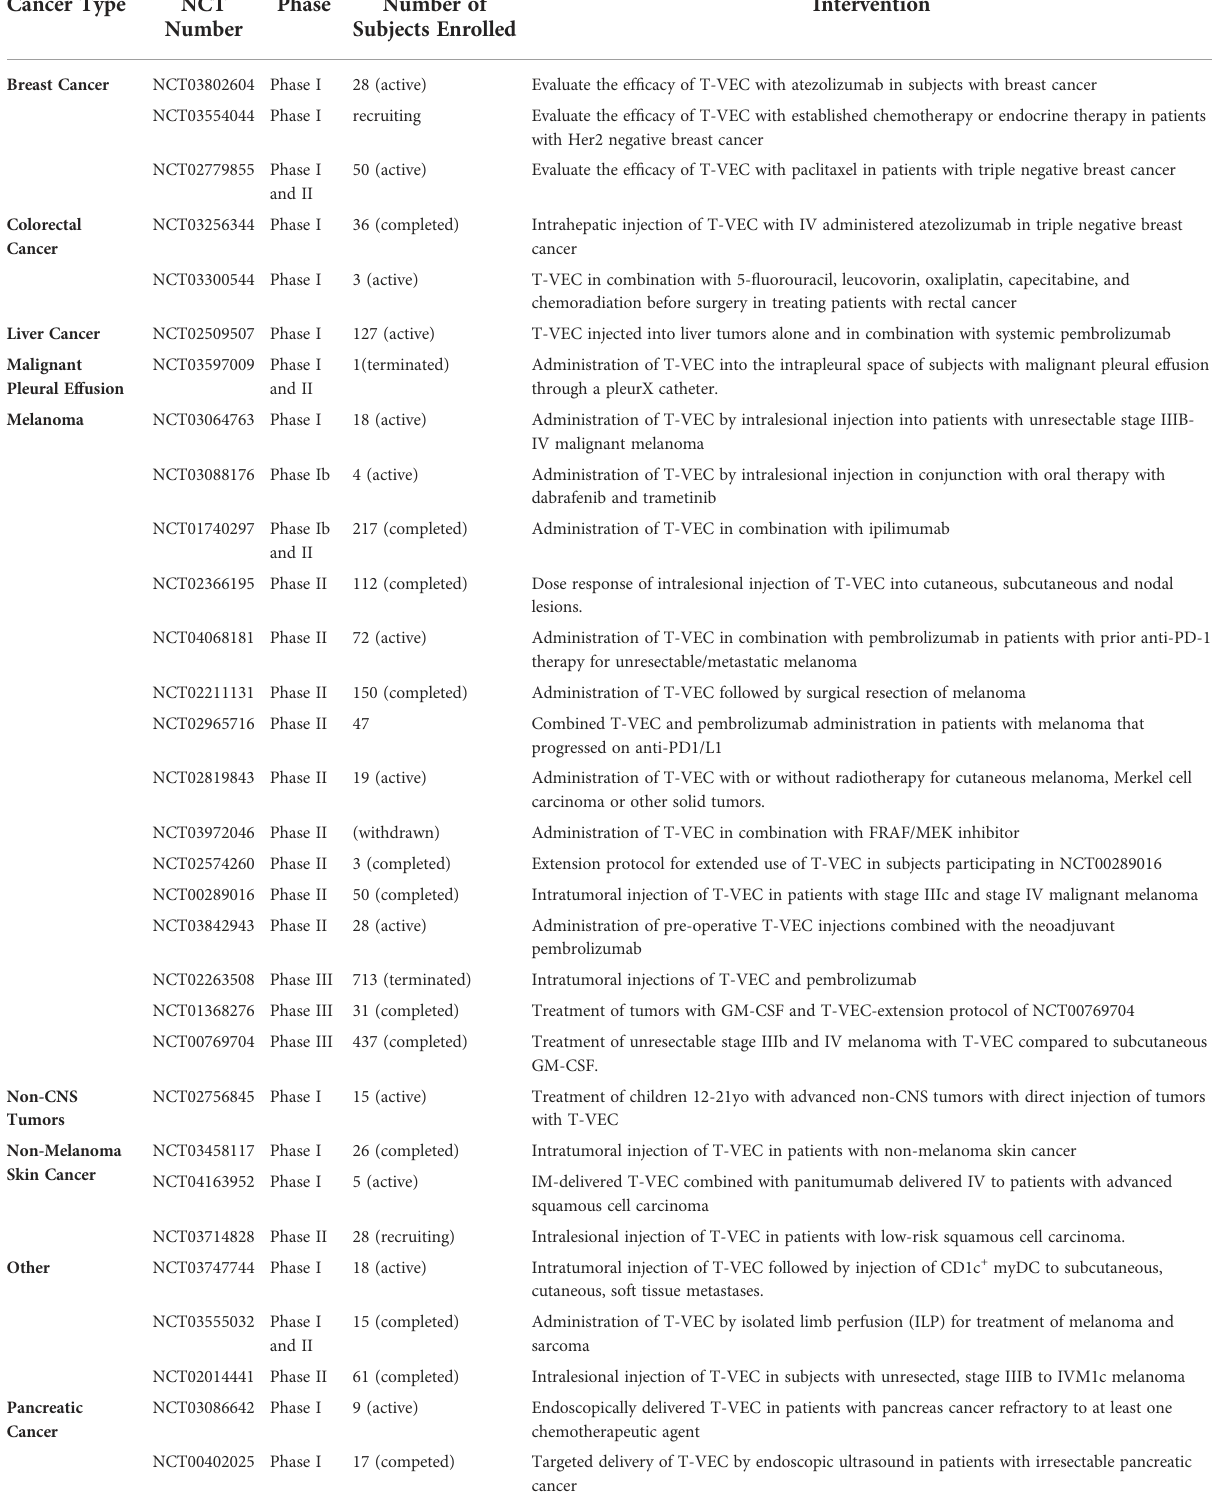
TABLE 3 Current T-VEC Clinical